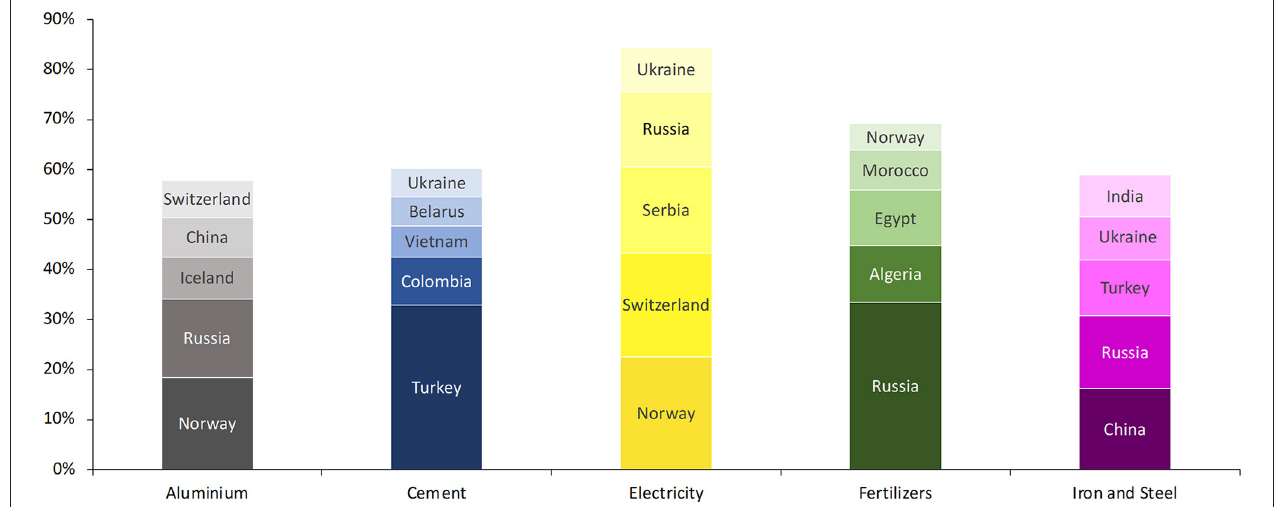
FIGURE 1 | Top five trade partners in the five sectors under EU CBAM (Source: COMTRADE). The data reflects the state before February 2022, and sanctions imposed on Russia and Belarus, as well as constraints on exports from Ukraine due to the war should be